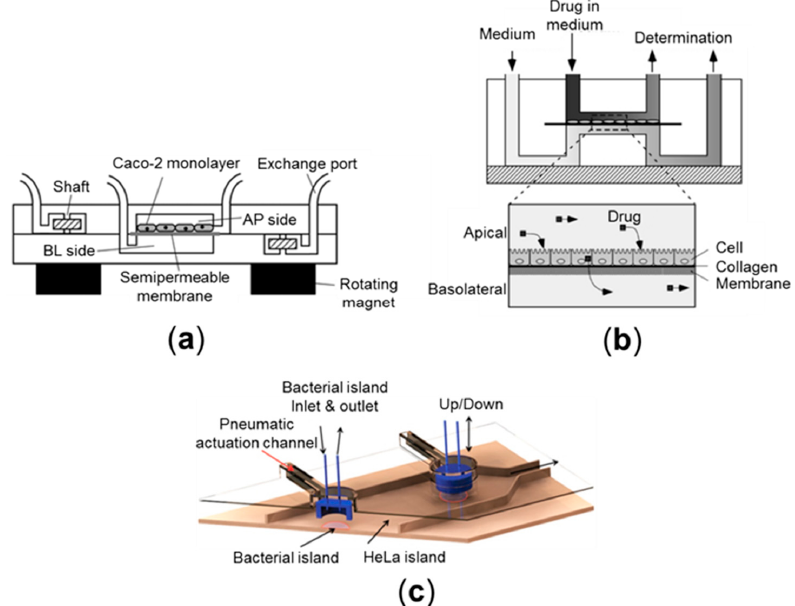
Figure 2. Schematic illustrations of microfluidic models mimicking human intestinal pathophysiology: ( a ) a microfluidic device consists of upper (AP side) and lower (BL side)